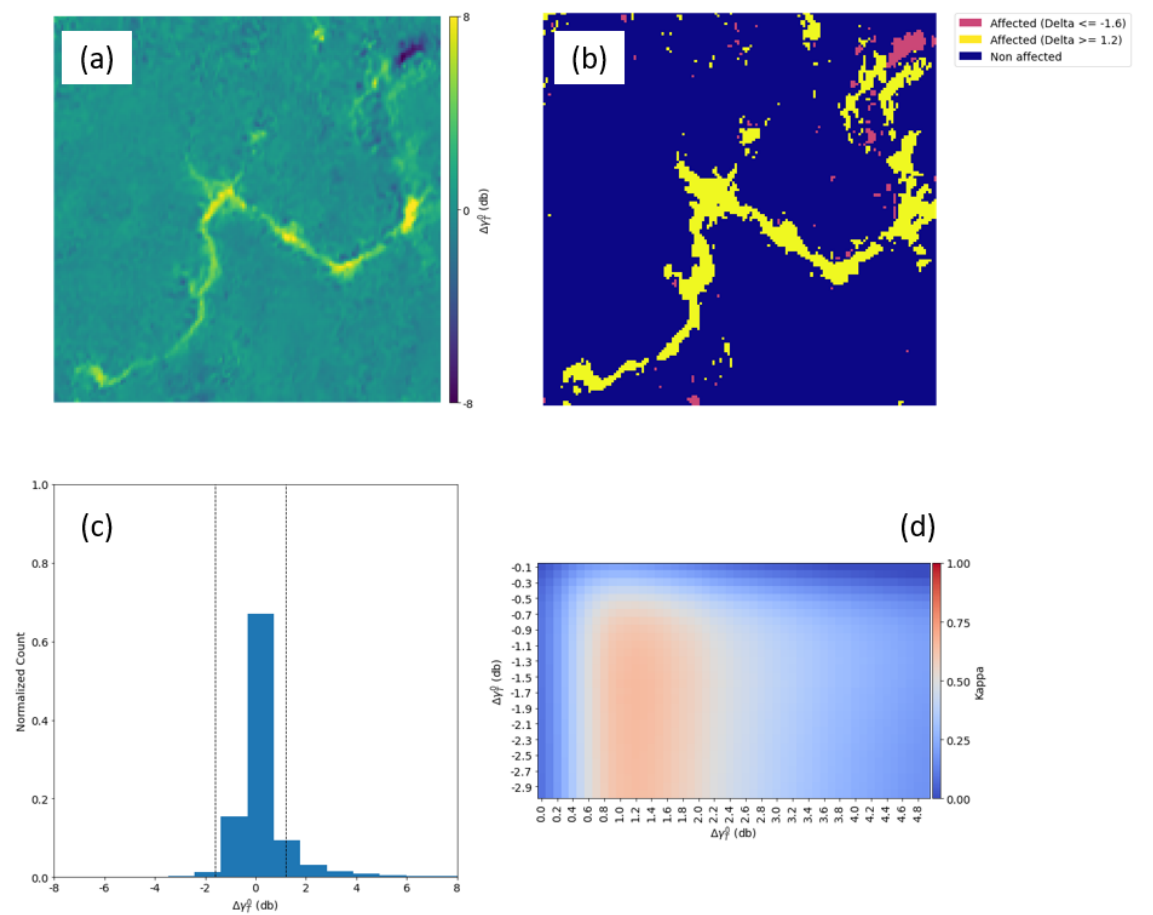
Figure 15. Brumadinho ConvLSTM Delta image of VH polarization ( a ), Flood Proxy Map ( b ), Histogram of Delta image ( c ), and Cohen’s Kappa heatmap ( d ). A higher Kappa value of the FPM was obtained with VH polarization. The best